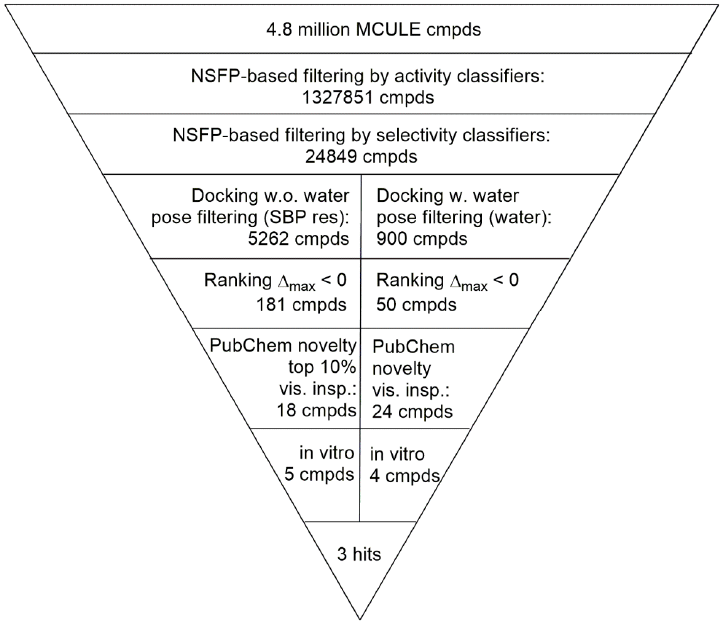
Figure 4. Flowchart of the virtual screening cascade used for the identification of 5-HT 2B selective hits.